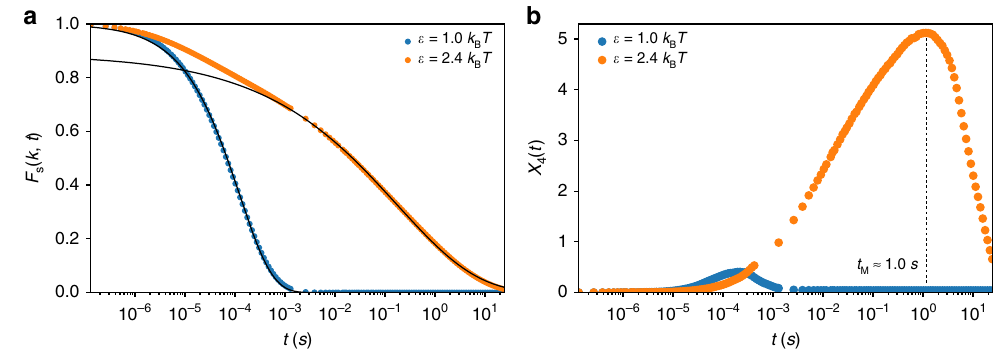
Fig. 6 Chromosomes exhibit glassy dynamics. a Intermediate scattering function obtained for ϵ = 1.0 k B T (blue) and ϵ = 2.4 k B T (orange). The line shows an ð k ; t Þ (cid:4) e (cid:2)ð t = t α Þ β with β = 0.27, for t exceeding a few milliseconds (black curve). b The fourth exponential function fi t, F s ( k , t ), for ϵ = 1.0 k B T . For ϵ = 2.4 k B T , F s order susceptibility, χ 4 ( t ), used as a function to demonstrate dynamic heterogeneity. The peak in χ 4 ( t ) for ϵ = 2.4 k B T around t M ≈ 1 s is a signature of